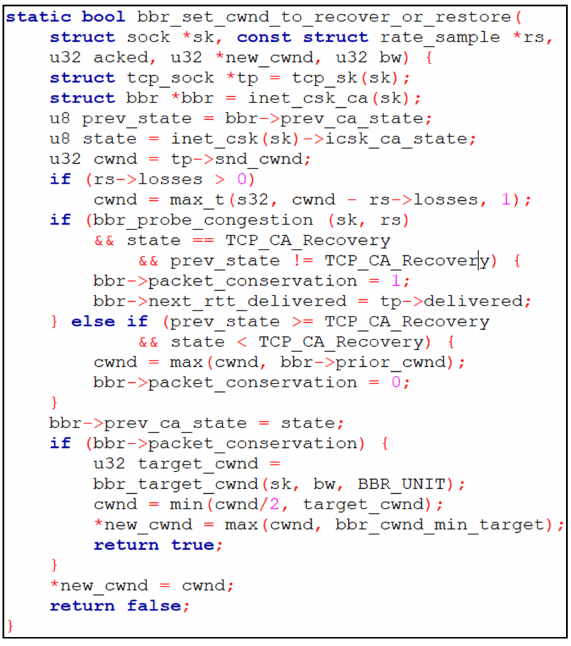
Figure 7. Linux Kernel code of the modified bbr_set_cwnd_for_recover_or_restore() function.